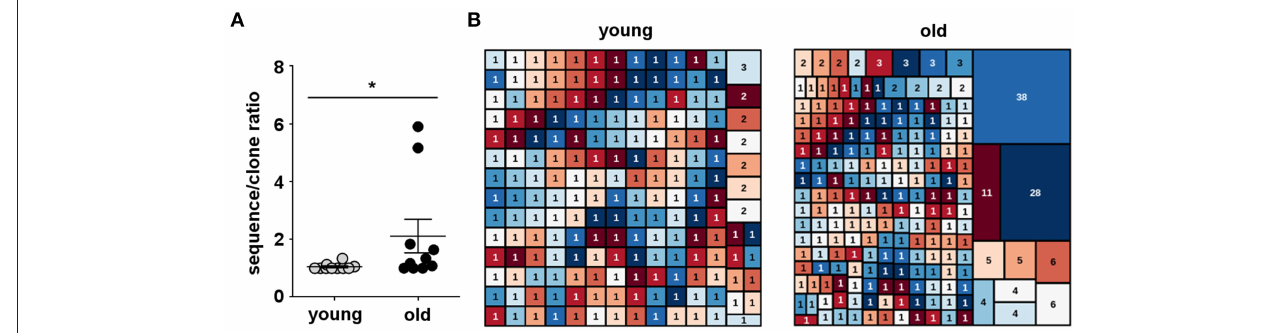
FIGURE 5 | Human B-1 cell antibody diversity declines with advancing age. Single B-1 cells were sorted into 96-well plates, and IgM heavy chains (IGHM) were individually amplified for sequence analysis. IGHM genes were analyzed by IMGT V-QUEST and then clustered into clones by CDR-H3 DNA sequence similarity. (A) The total number of IGHM sequences of each donor sample divided by the number of unique IGHM rearrangements in the same sample (sequence/clone ratio) is shown for B-1 cell antibodies from young and old donors. * p < 0.05 by Mann–Whitney U -test, bars are means and standard errors of the means (SEM). (B) Tree map representation of IGHM repertoires from B-1 cells isolated from young (20–45 years) and old (65–88 years) donors, where each rectangle represents a unique V(D)J rearrangement and the area of each rectangle denotes the relative frequency of an individual sequence. Each graph represents the frequency of IGHM clonotypes in the B-1 cell pool from all the young ( n = 10) or all the old ( n = 10) donors. The numbers shown inside the rectangles indicate the sizes of the clones.